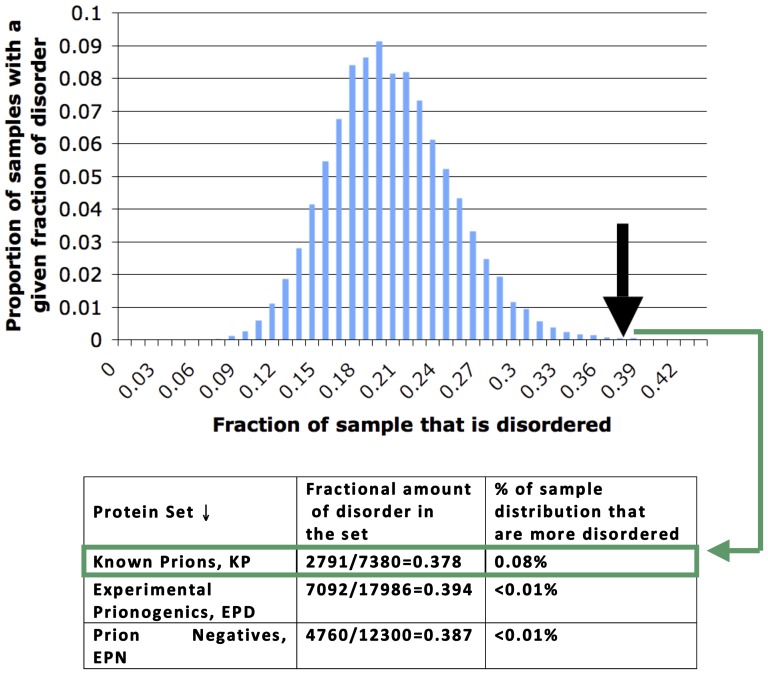
Disorder content of known prions (KPs), experimental prionogenic domains (EPDs) and prion negatives (EPNs).Monte Carlo samples (n = 10000) of the same total protein length as each of the three data sets were made and the total amount of disorder (from the DISOPRED2 program [25]) was annotated. A fractional piece of one protein was used to make up the exact residue count for the sample size. The plot shows the distribution of disorder content for these samples for the KP set. The actual observed value is indicated by an arrow. The % of samples that have greater disorder than the observed value for each data set is indicated in the table below the histogram.